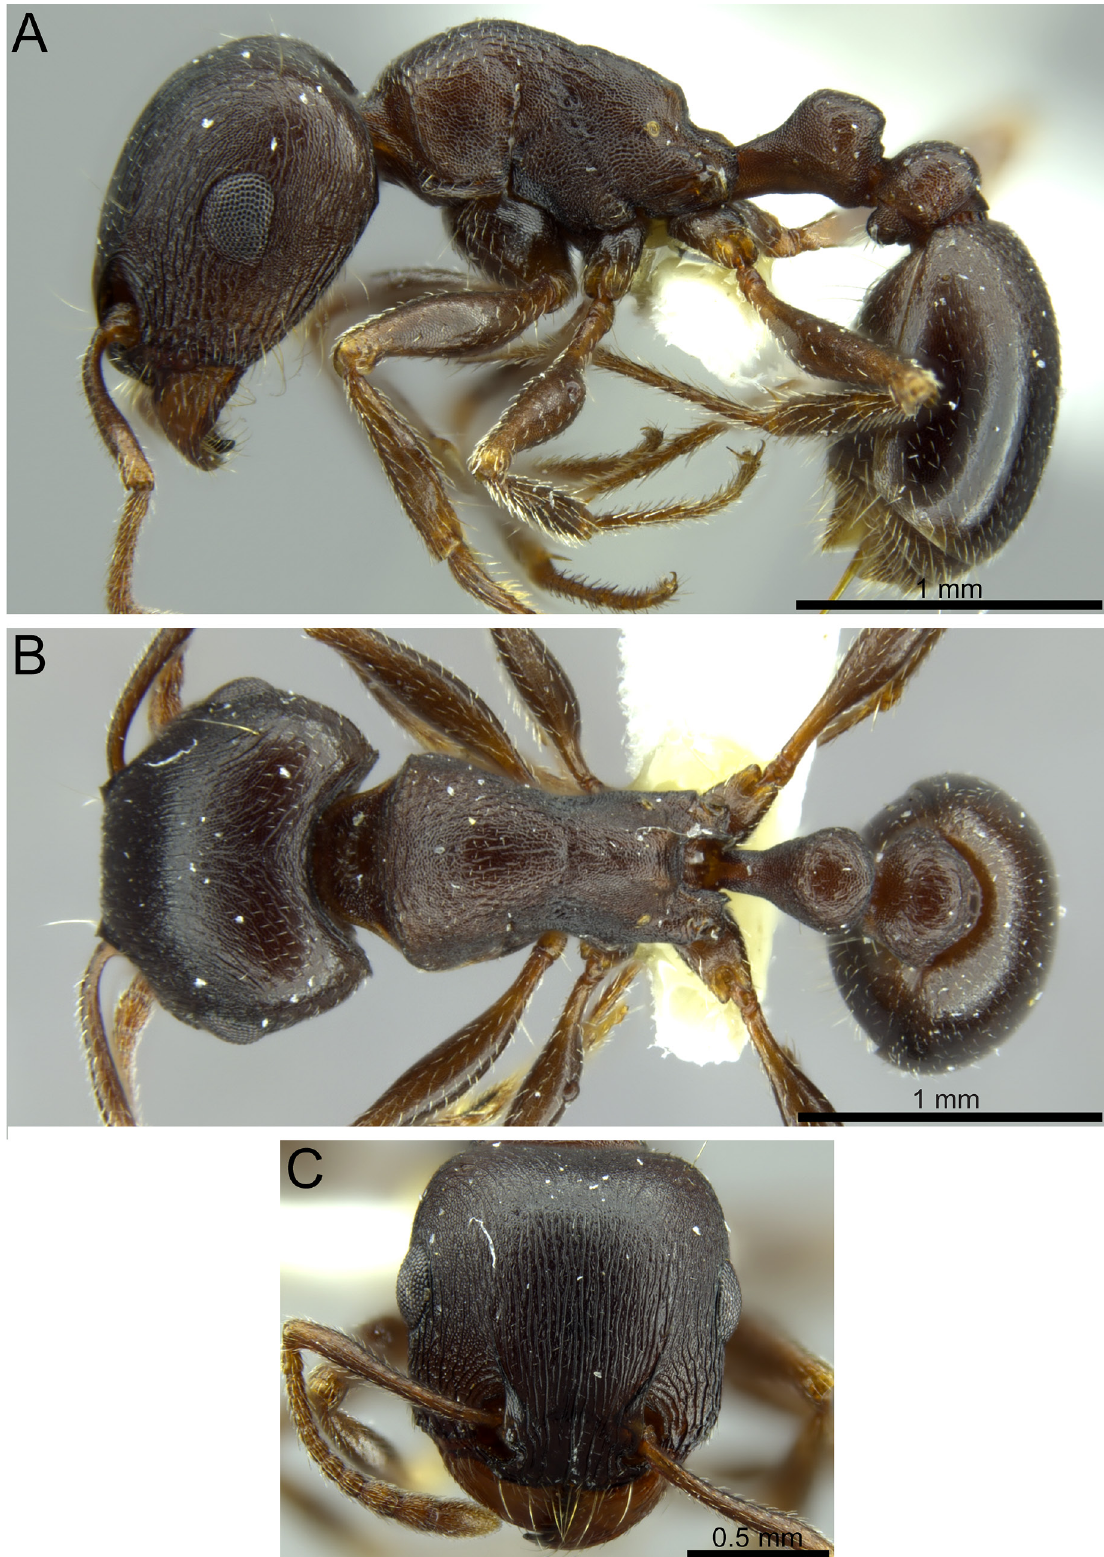
Fig. 14. Tetramorium jordani Santschi, 1937 (CASENT0248475). A . Body in profile. B . Body in dorsal view. C . Head in full-face